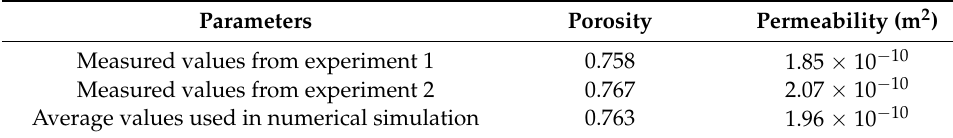
Figure 18. Relationship between flow front displacement and capacitance in the second RTM experi- ment using a seven-layer fiber preform.